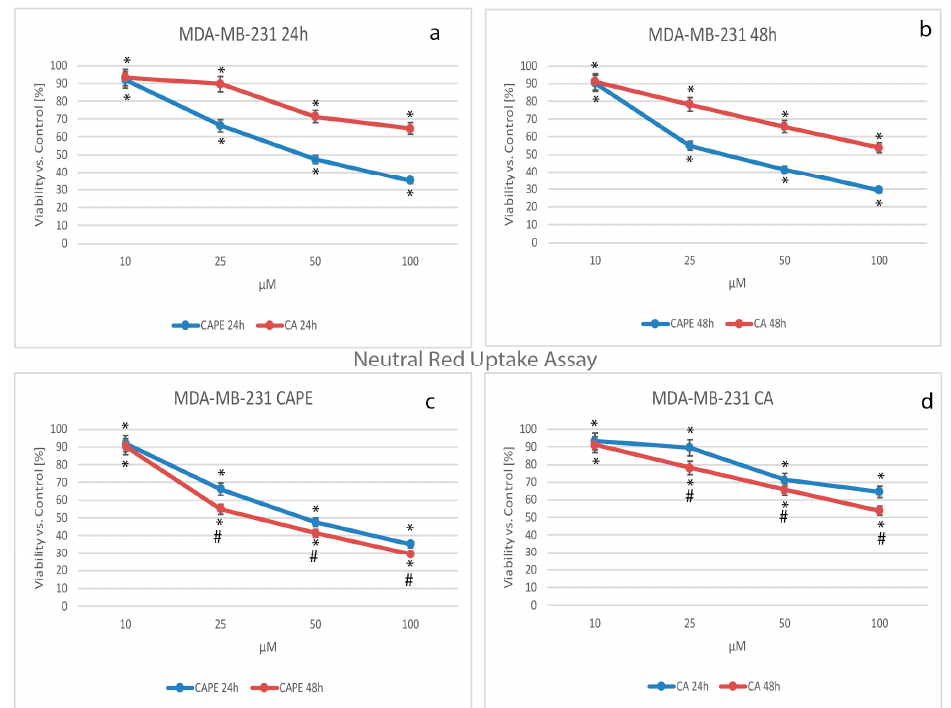
Figure 3. Cytotoxic effects of caffeic acid phenethyl ester (CAPE) and caffeic acid (CA) were